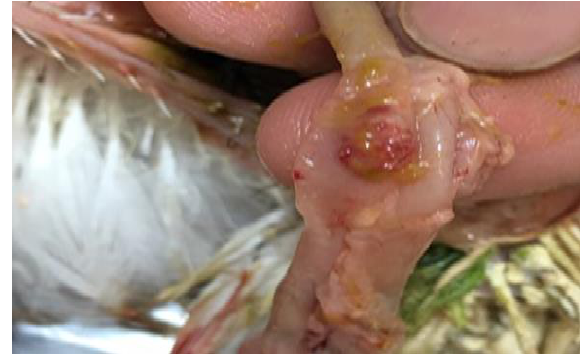
Figure,3: Opened caeca of the broiler intestine showed the edematous inflammation and bloody necrotized foci.